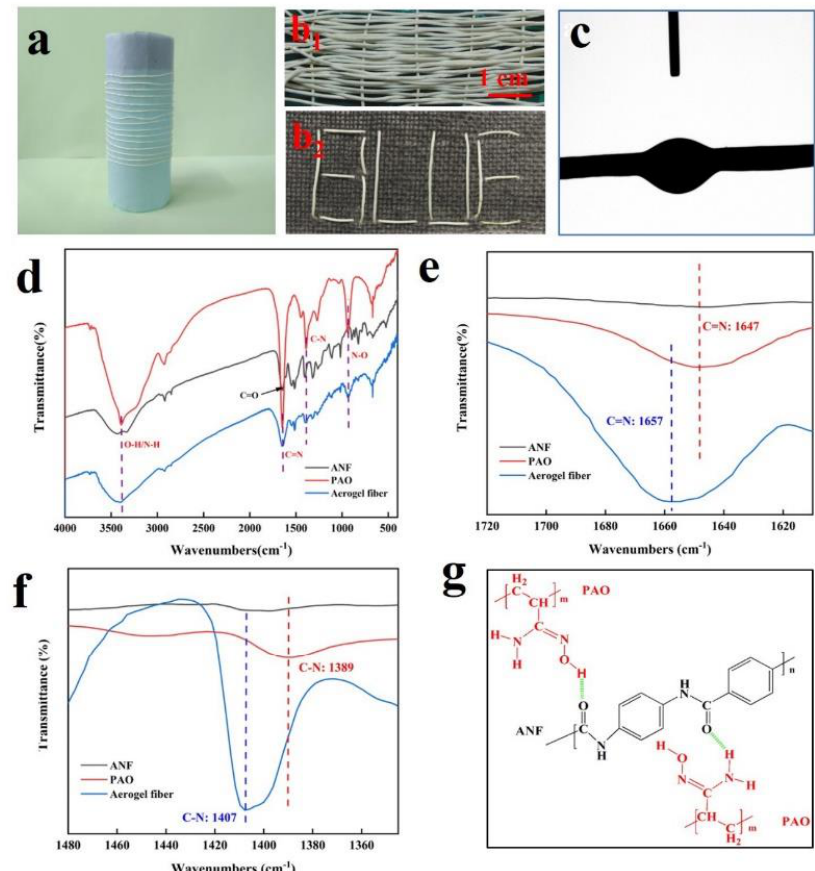
Figure 1. ( a ) Photograph of the PAO@ANF aerogel fibers collected with a roller; ( b 1 ) The free-standing fabric woven from the aerogel fibers; ( b 2 ) a letter pattern knitted on a cotton fabric; ( c ) contact angle of a single PAO@ANF aerogel fiber; ( d ) FTIR spectra of ANF, PAO and PAO@ANF aerogel fiber; and ( e , f ) magnified plot of FTIR spectra showing the peak positions associated with the C=N and C-N; ( g ) chemical structure of PAO and ANF, as well as the diagram of their hydrogen bonding interactions.